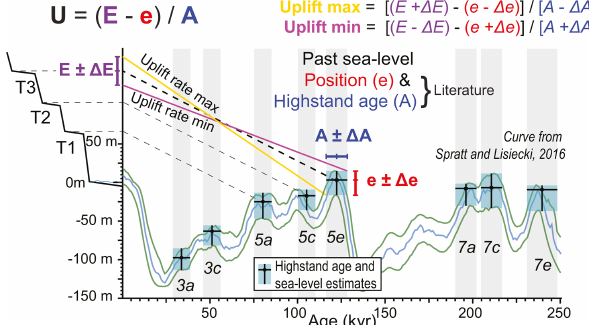
Figure 3. Uplift calculation method. The curve shown is PC 1 with bootstrapping 2.5th and 97.5th percentile from Spratt and Lisiecki (2016). Light gray bands are the MIS ages from the lit- erature reported in Table B.2 in Supplement